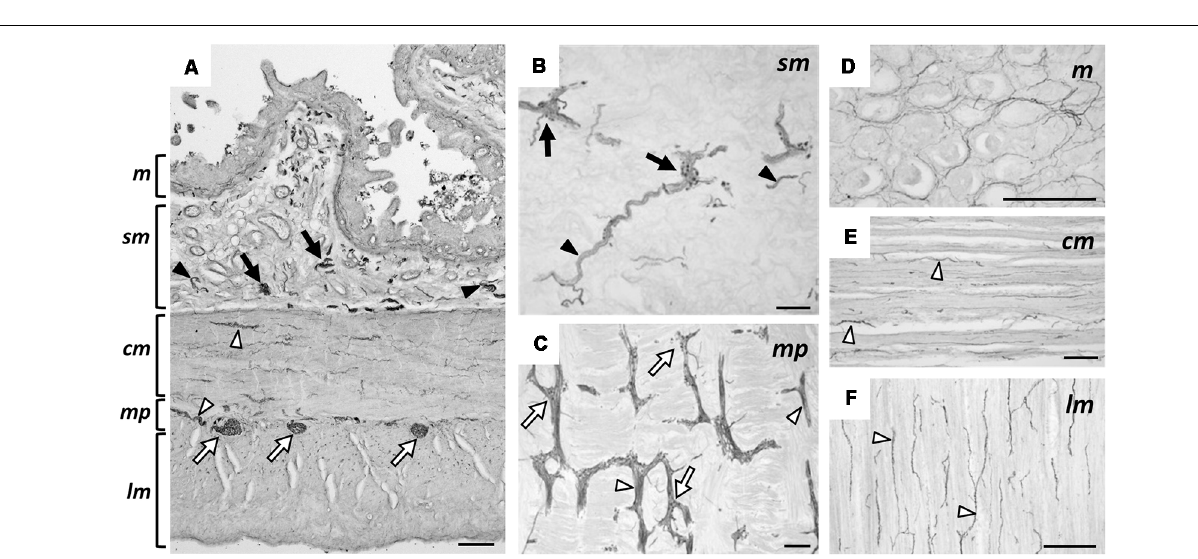
(arrows) and nerve fiber bundles (arrowheads). In